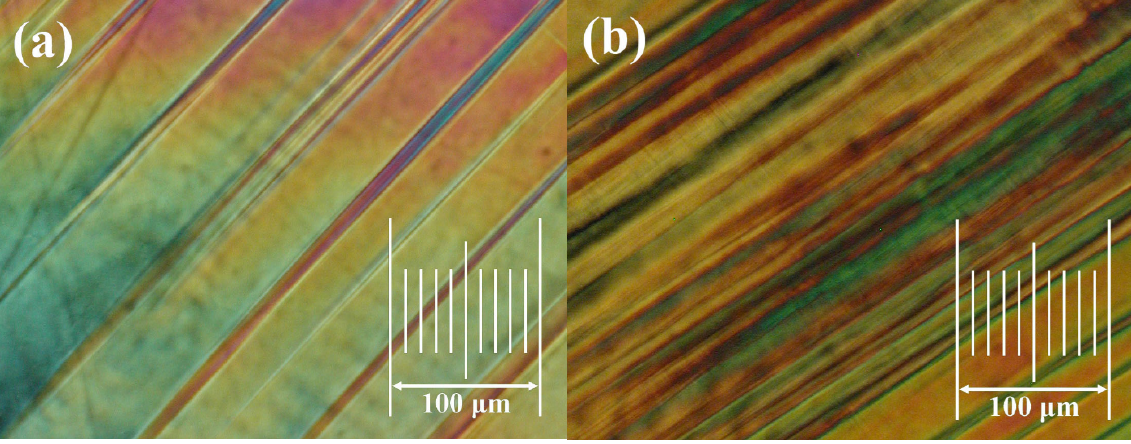
Figure 4. Room temperature domain structures of [001]-oriented NBT ( a ) and NBT:Mn ( b ) single crystals. Reprinted with permission from [27]. Copyright 2008